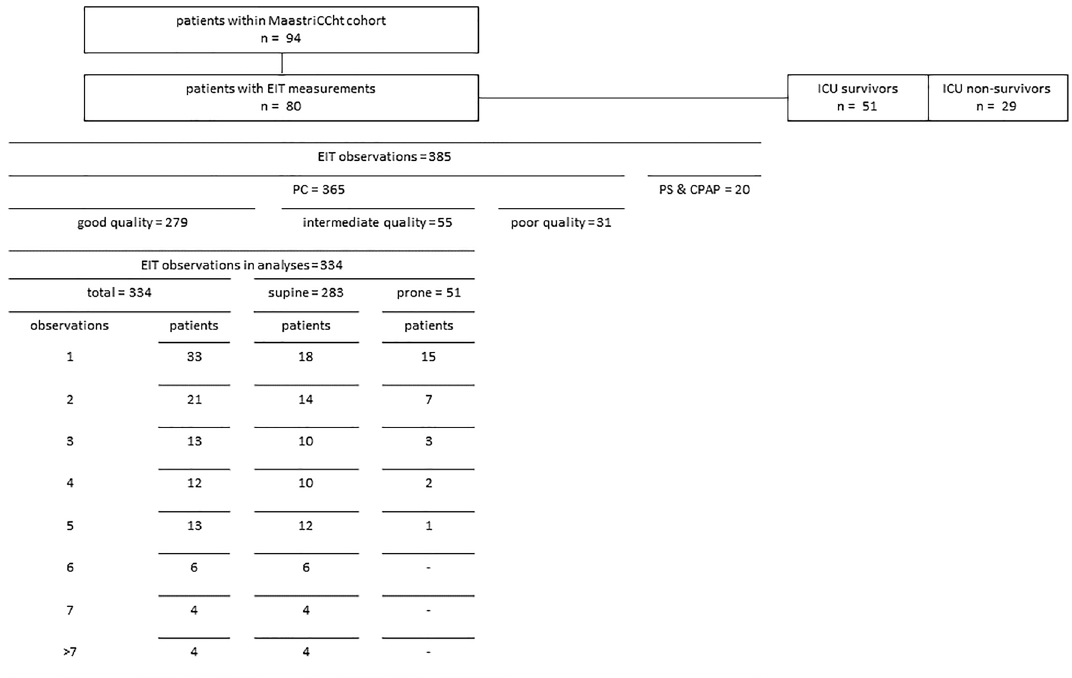
Figure 1. Study sample. Patients and good and intermediate quality serial EIT measurements during pressure control mode ventilation. Observations > 7 may include a range of 8 to 17 EIT observations, resulting in a total of 334. ICU, intensive care unit; EIT, electrical impedance tomography; PC, pressure control mode ventilation; PS, pressure support mode ventilation; CPAP, continuous positive airway pressure mode